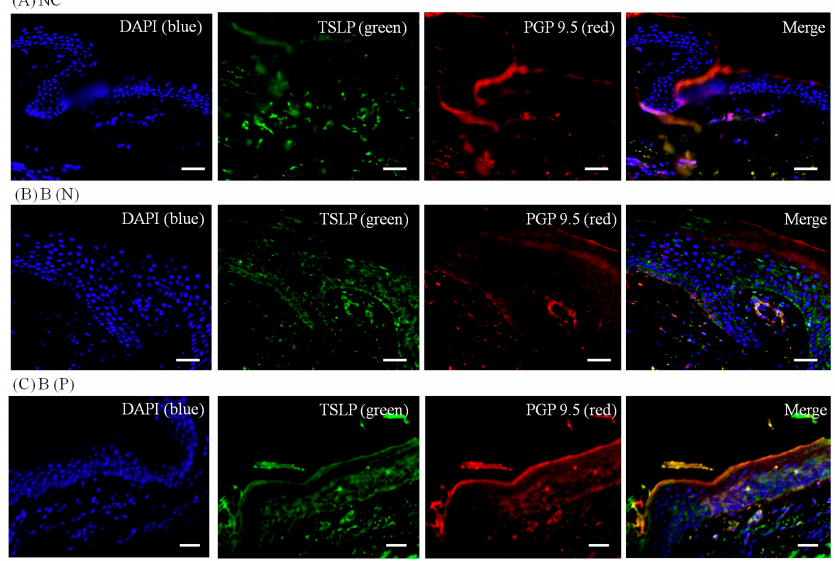
Figure 7. Three-color immuno fl uorescence confocal images were obtained for 4 ′ ,6-diamidino-2- phenylindole (DAPI), blue ), TSLP ( green ) and protein gene product 9.5 (PGP 9.5, red ) from tissues of ( A ) normal; ( B ) nonpruritic and ( C ) pruritic burn scars. The staining of TSLP, well observed in the spinous layer of the epidermis, was least in ( A ) normal control and greatest in ( C ) pruritic burn-scar tissue. NC: keratinocytes from normal control; B (N): keratinocytes from a nonpruritic burn scar; B (P): keratinocytes from a pruritic burn scar; TSLP: thymic stromal lymphopoietin. Scale bars = 50 μ m.